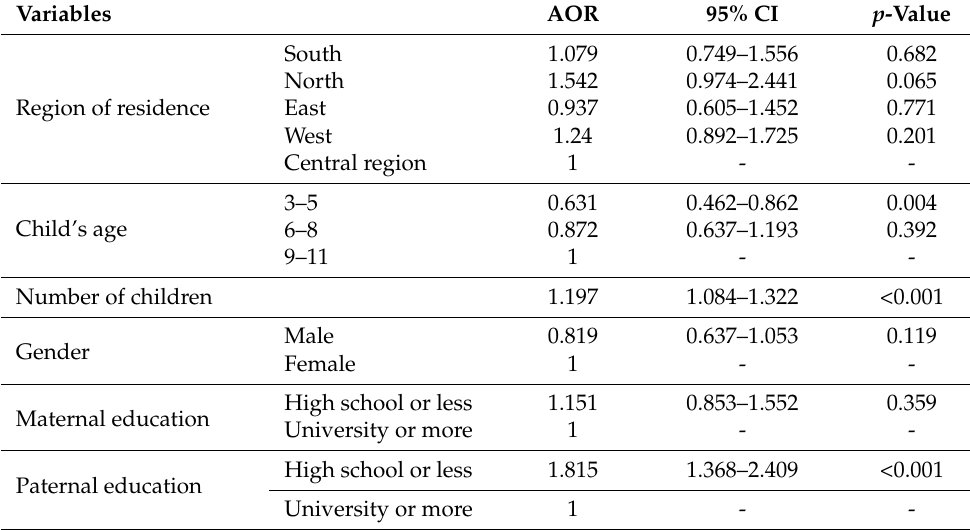
Table 3. Binary regression analysis showing the association between parents reporting barriers to dental care and sociodemographic